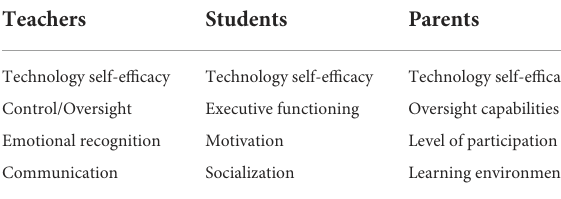
TABLE 2 Mean scores on pre and post attitudinal surveys. TABLE 3 Classification table of core